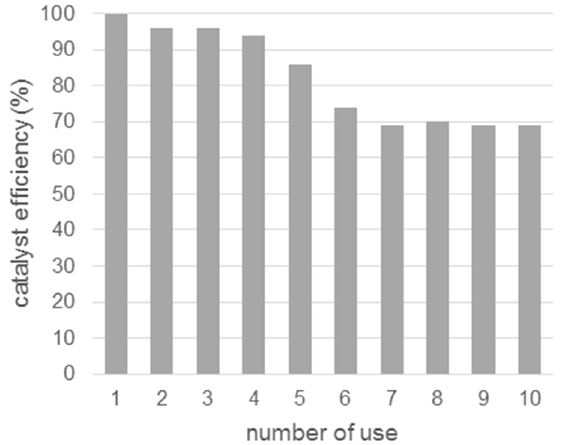
Figure 4. Recyclability of the NP-PEIP@Pd catalyst for coupling p-tolylboronic acid and 1-iodo-4- methoxybenzene.